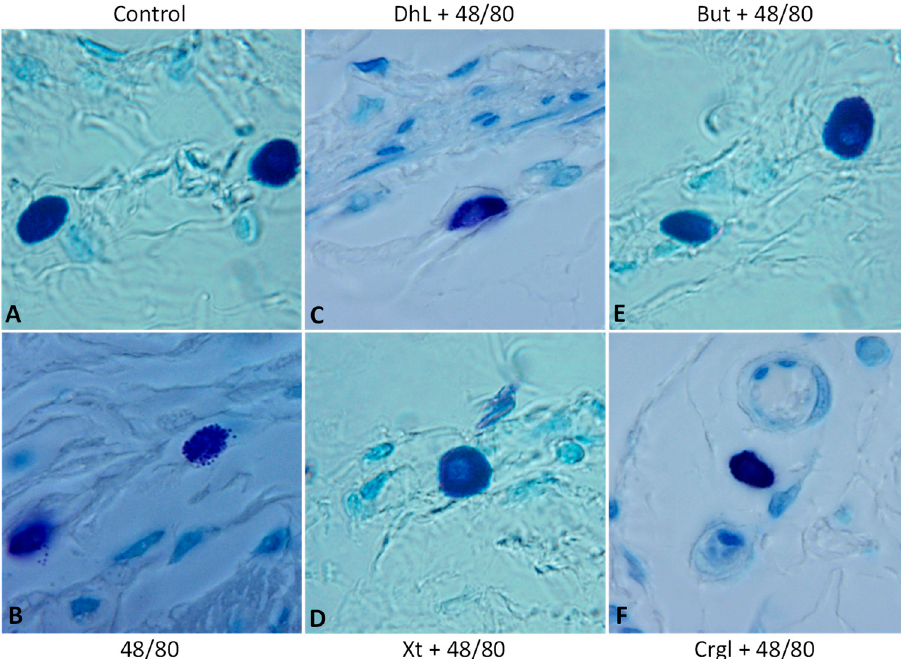
Figure 6. Paraffin sections (6 µm) of gastric walls stained by toluidine blue. Representative mast cells can be seen. ( A ) Control; ( B ) compound 48/80; ( C ) DhL + compound 48/80; ( D ) Xt + compound 48/80; ( E ) But + compound 48/80; ( F ) Crgl + compound 48/80. ×600.